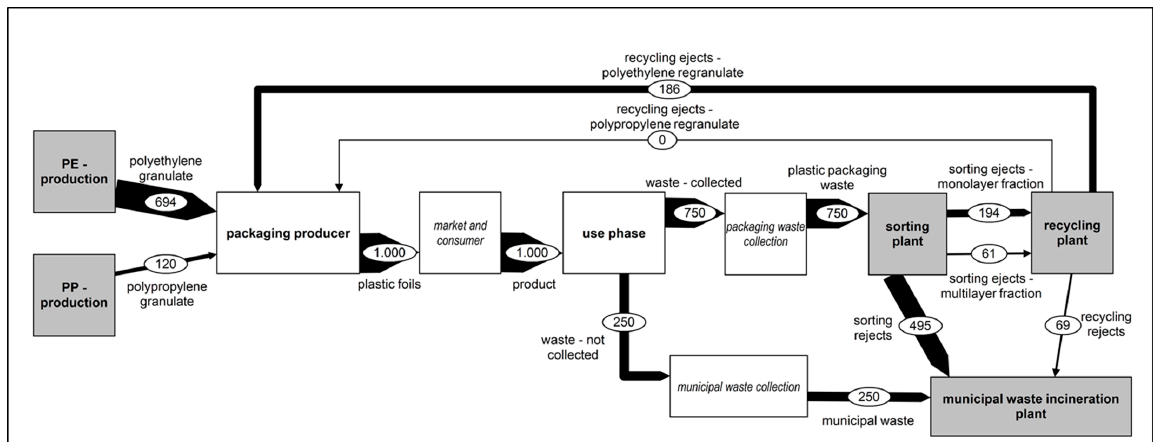
Figure A2. Material flows—Scenario 1—Status Quo.